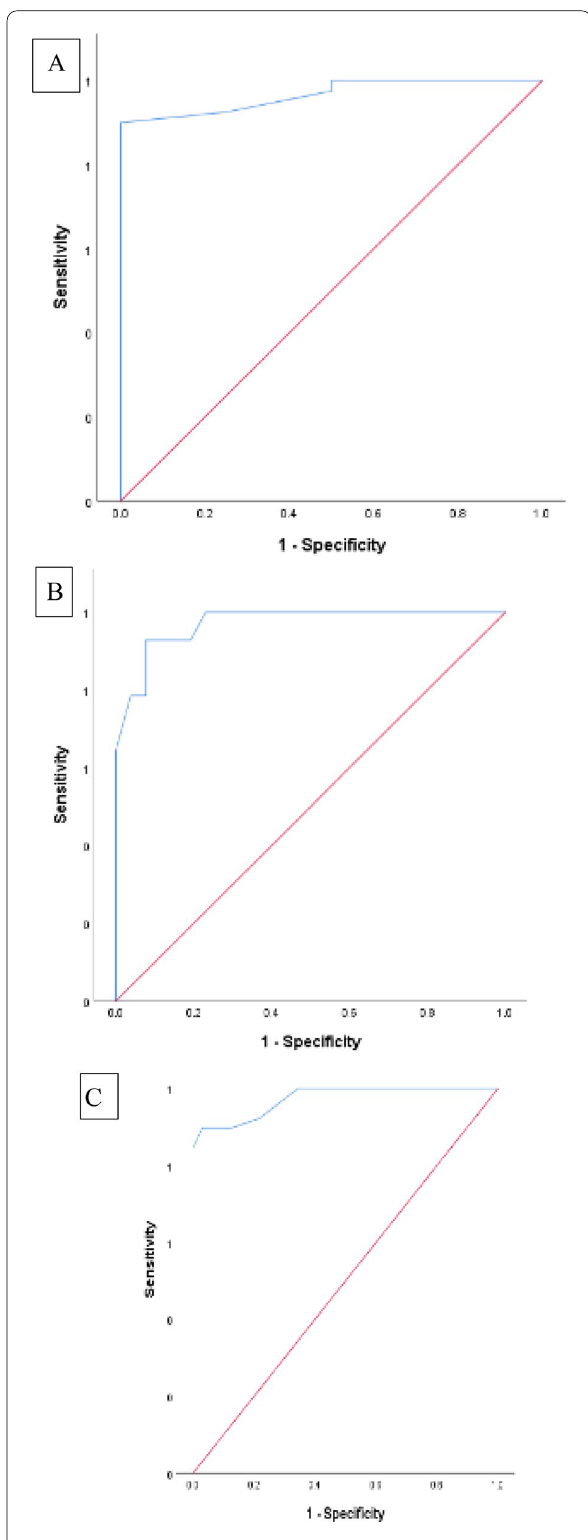
Fig. 1 A ROC curve OF PET/CT revealed its sensitivity, specificity, and the SUV max cutoff point for diagnosis of HCC, B ROC curve of 18F FDG PET/CT revealed sensitivity, specificity, and an SUV max cutoff point of > 5.57 for predicting that HCC has extrahepatic metastases and predicting stage C, C ROC curve of 18F FDG PET/CT revealed sensitivity and specificity with an SUV max cutoff point of > 3.35 for differentiating between metastatic and nonmetastatic